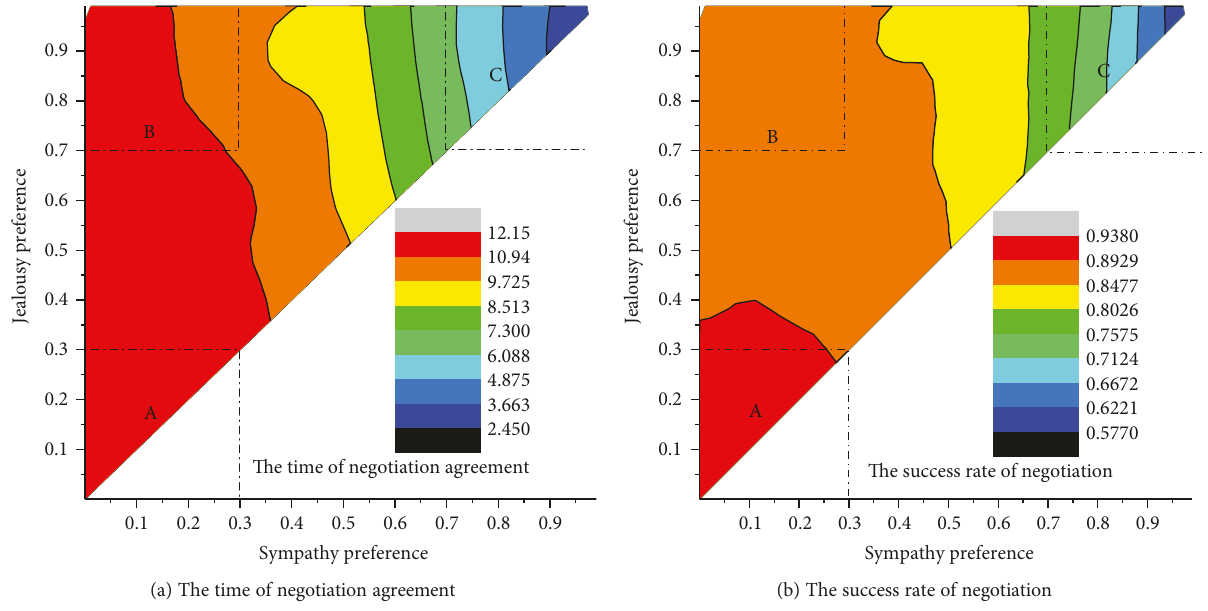
Figure 5: The negotiation results under di ff erent combinations of empathy and jealous preference.